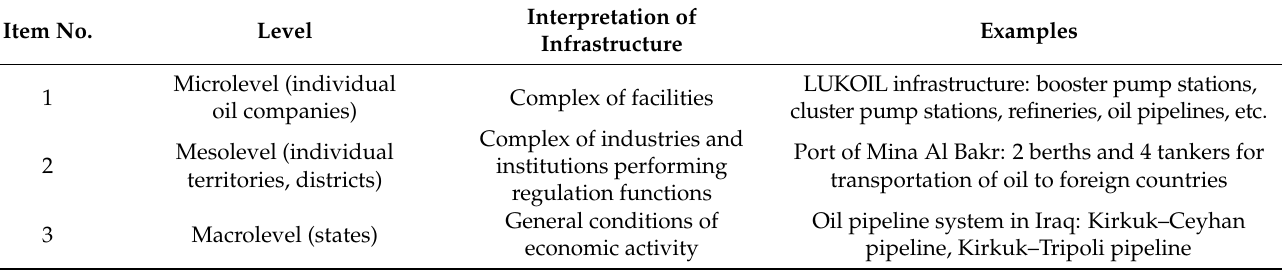
Table 1. Oil industry infrastructure by